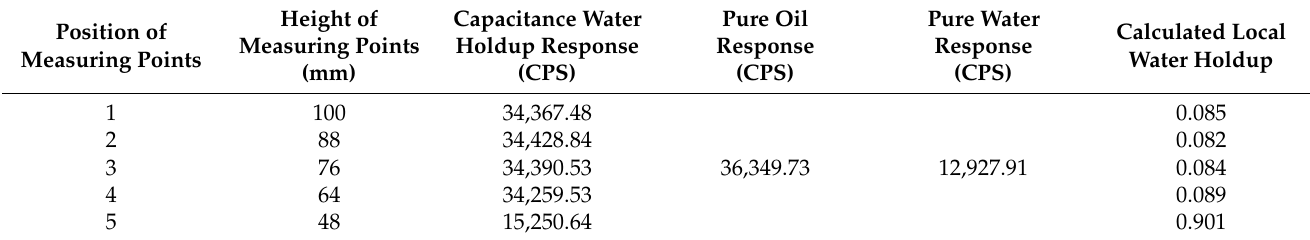
Table 2. Local water holdup at different positions